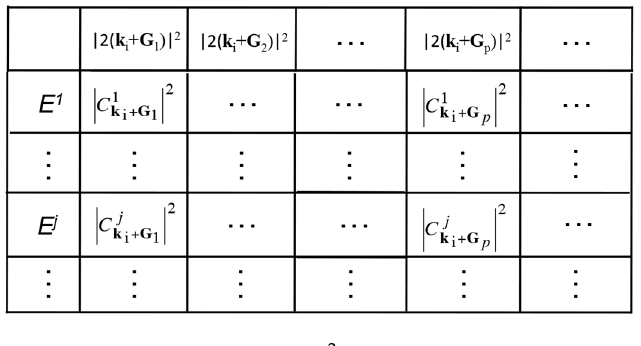
2 (cid:12) (cid:12) 2 j (cid:12) (cid:12) pj , at the wave vector k i as functions of the energy (cid:12) C (cid:12) , at the wave vector k i as functions of the k i + G p + G i